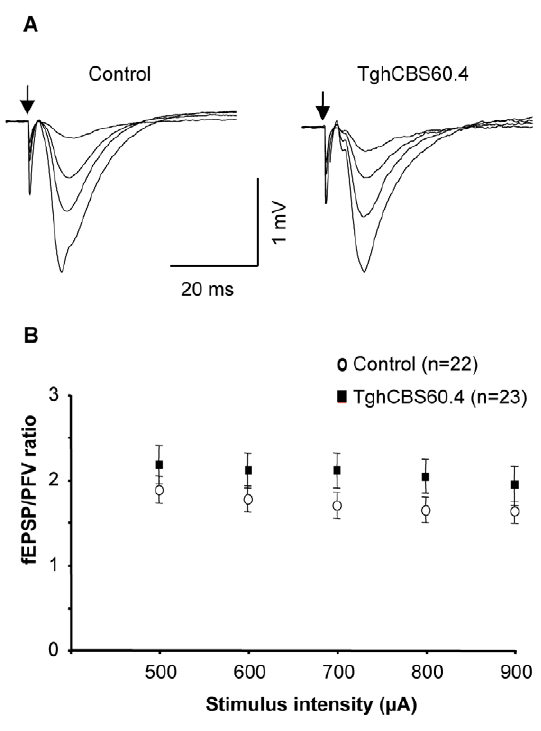
Figure 4. Basal synaptic transmission in Tg hCBS 60.4 mice. (A) Superimposed sample traces of evoked AMPA-R-mediated fEPSPs induced in a control (left) and a Tg hCBS 60.4 mouse (right) by increased intensities of electrical stimulation of glutamate afferents (arrow). Traces are averages of 3 consecutive responses. (B) Comparison of synaptic efficacy as determined by the fEPSP/PFV ratio calculated at a stimulus intensity from 500 to 900 m A in Tg hCBS 60.4 (23 slices/5 animals) and control (22 slices/5 animals)